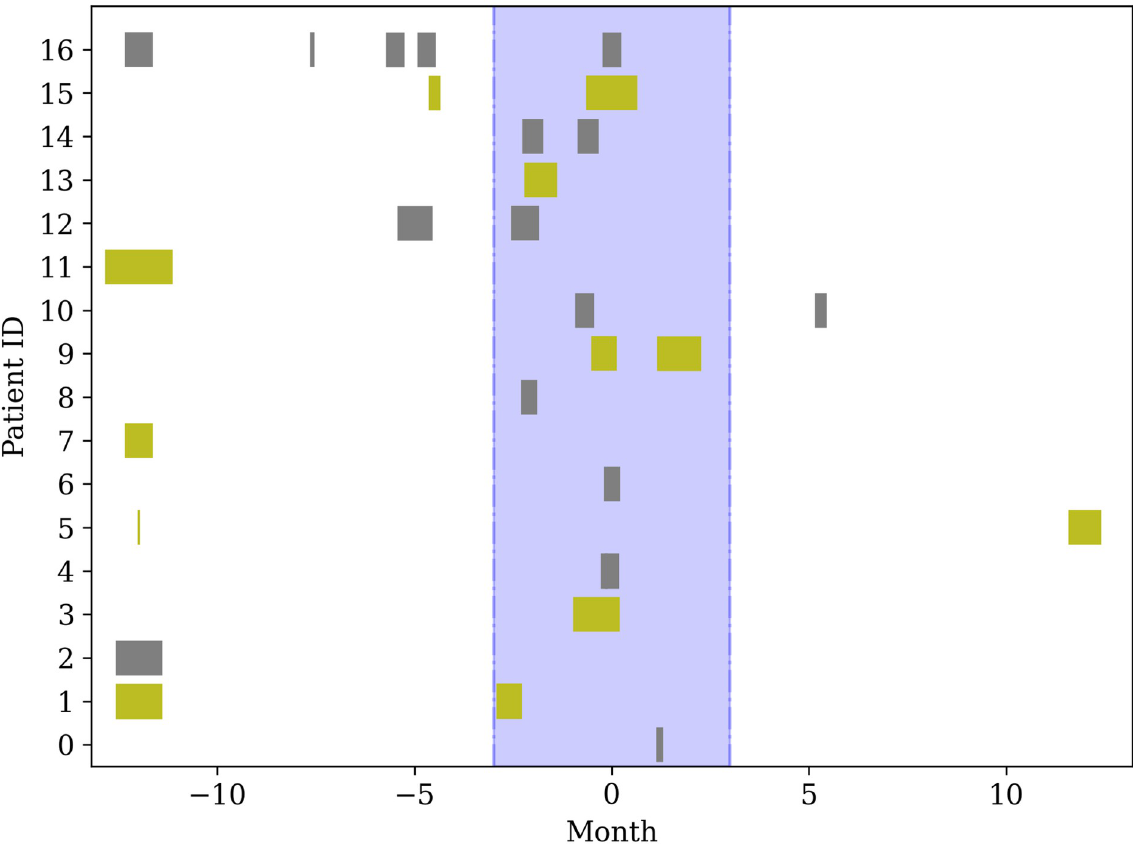
Fig 1. Hospitalization for pneumothorax compared with date of BHD diagnosis. The figure shows the onset and in-hospital period for pneumothorax per patient. The month zero is defined by the day of BHD diagnosis, and the shaded area is the previous 3 months of the diagnosis. The hospital admission period is depicted as the length of each bar.